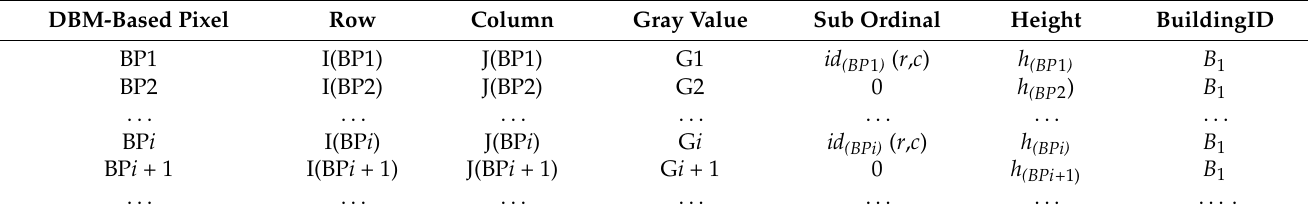
Table 1. The superpixel for the roof texture data-generated DBM-based building. DBM-Based Pixel Column Gray Value Sub